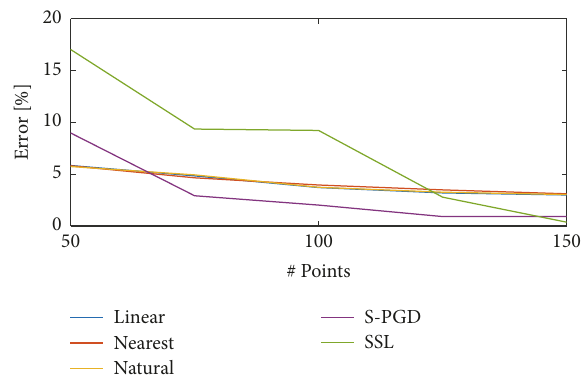
Figure 5: E L of 𝑓 1 (𝑥,𝑦) varying # P for different identification techniques. # L = 1000